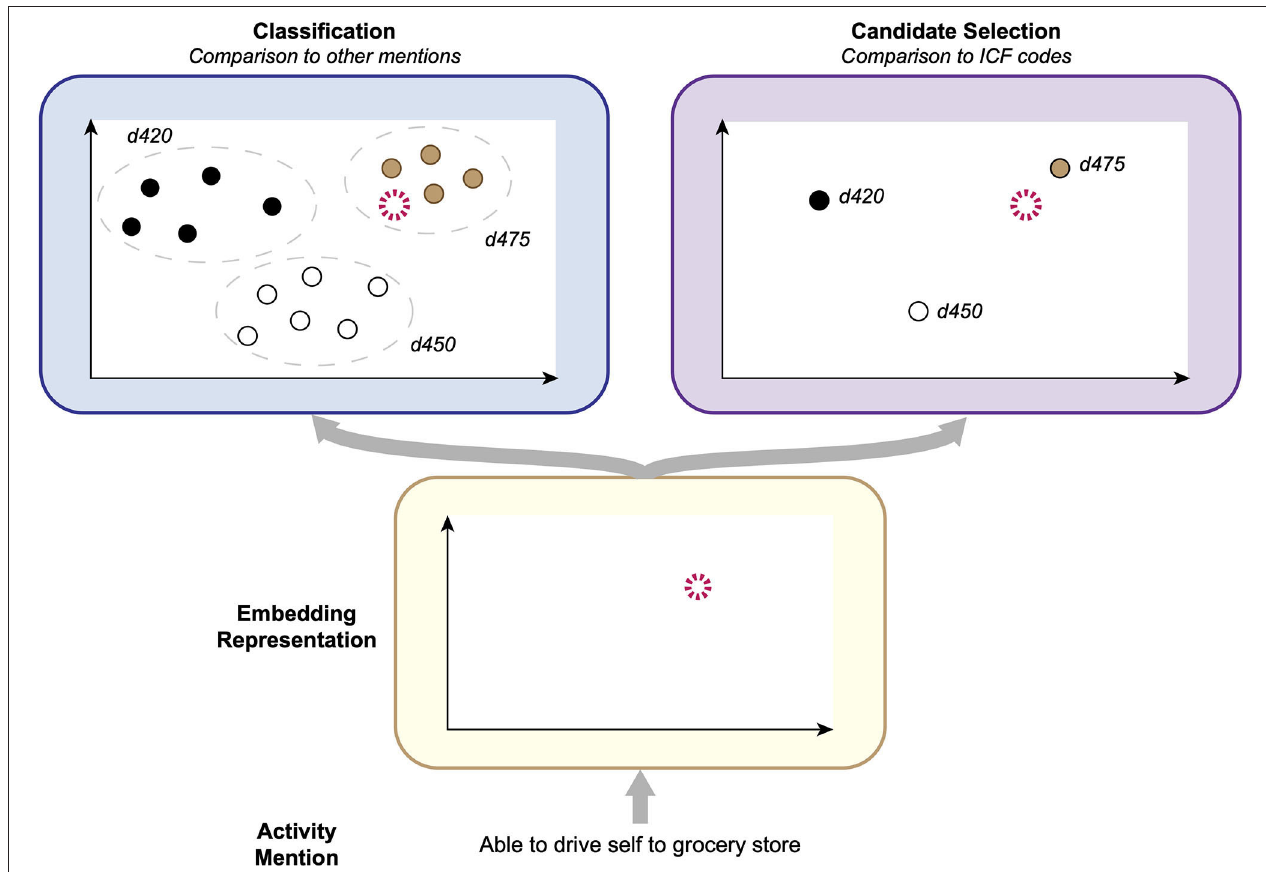
FIGURE 3 | Conceptual illustration of the ICF coding process. Given an activity mention, an embedding representation of the report is calculated and then compared with other activity mentions, in Classification; or available ICF categories, in Candidate Selection.